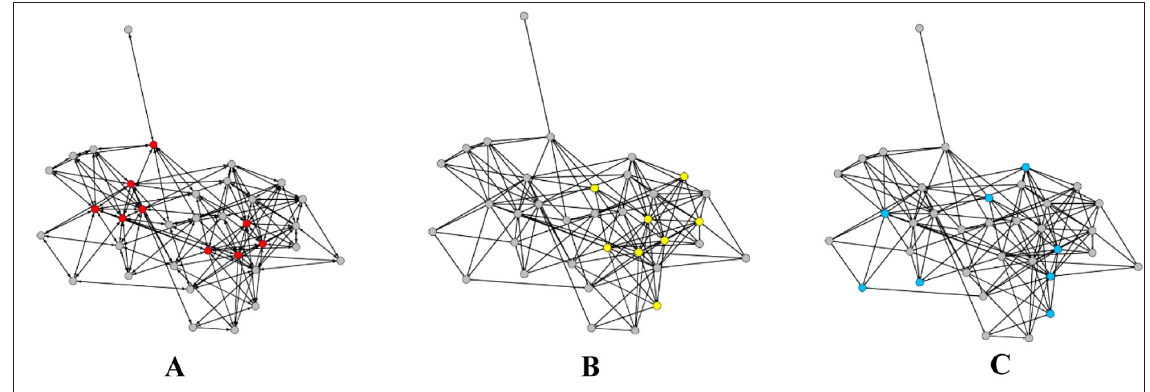
Figure 1 Preliminary results on breadboard pilot testing revealed: Central members (A) , Cluster of members (B) , and Random members (C) . Note : Dots = People; Lines = Connections; Colors = Selected